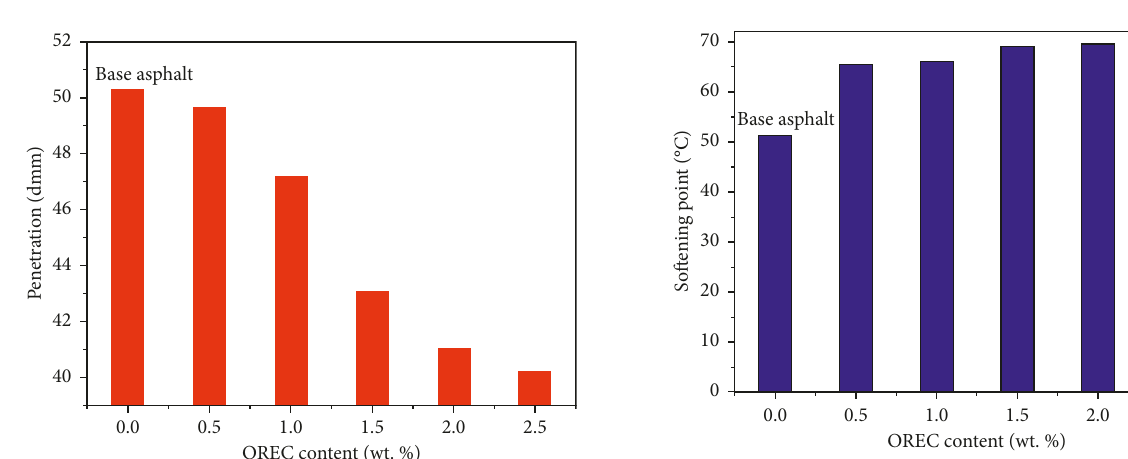
Figure 3: The softening point of WPP/OREC-modified asphalt.